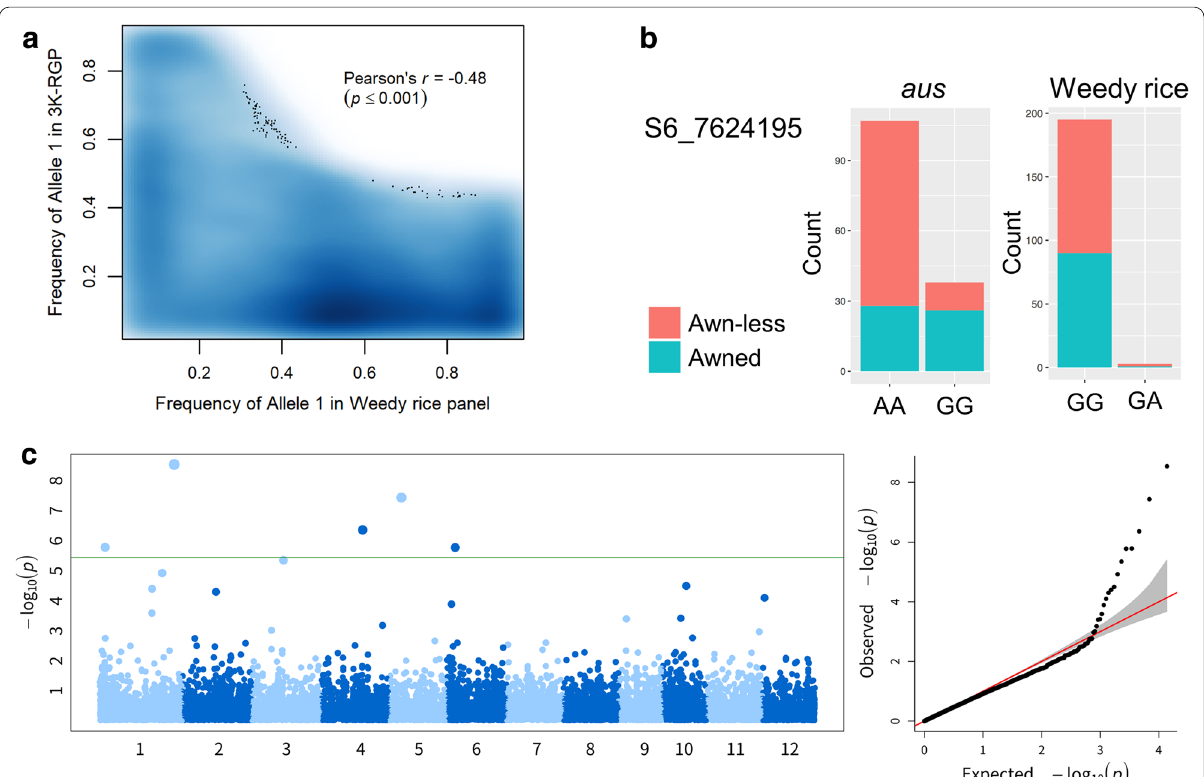
Fig. 8 Exploration on weedy rice data. a Distribution of allele frequency of a given allele between 41,044 common SNPs (MAF weedy rice panel and 3K‑RGP. High density is indicated by darker color; black dots are individual comparison. b Phenotype vs . genotype segregation of S6_7624195 in aus and in weedy rice panel. c GWAS results of weedy rice panel. The first two PC based on genome‑wide SNPs were included in the GWAS model to control for population structure. The green horizontal line showed the Bonferroni threshold at α